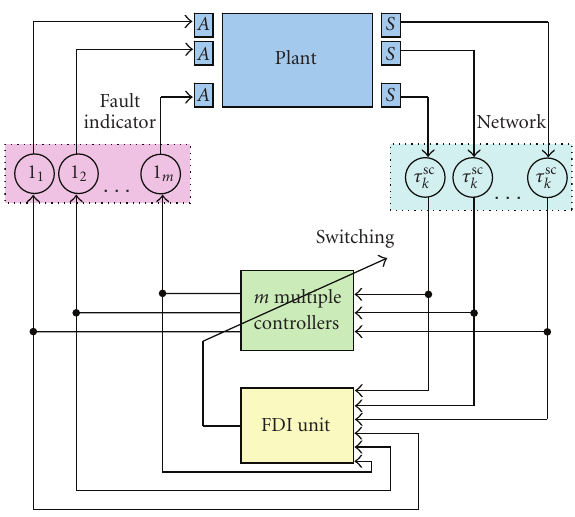
Figure 1: Networked control system with actuator